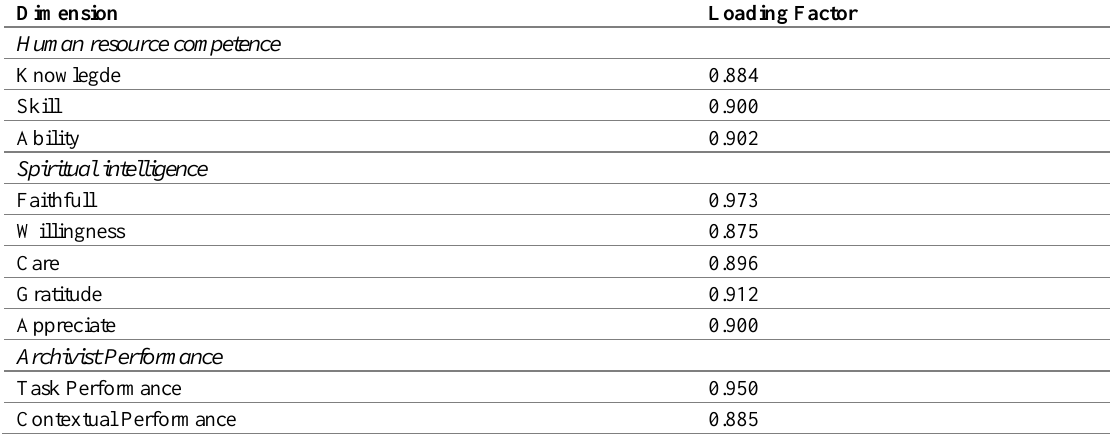
Table 2 : Confirmatory Factor Analysis